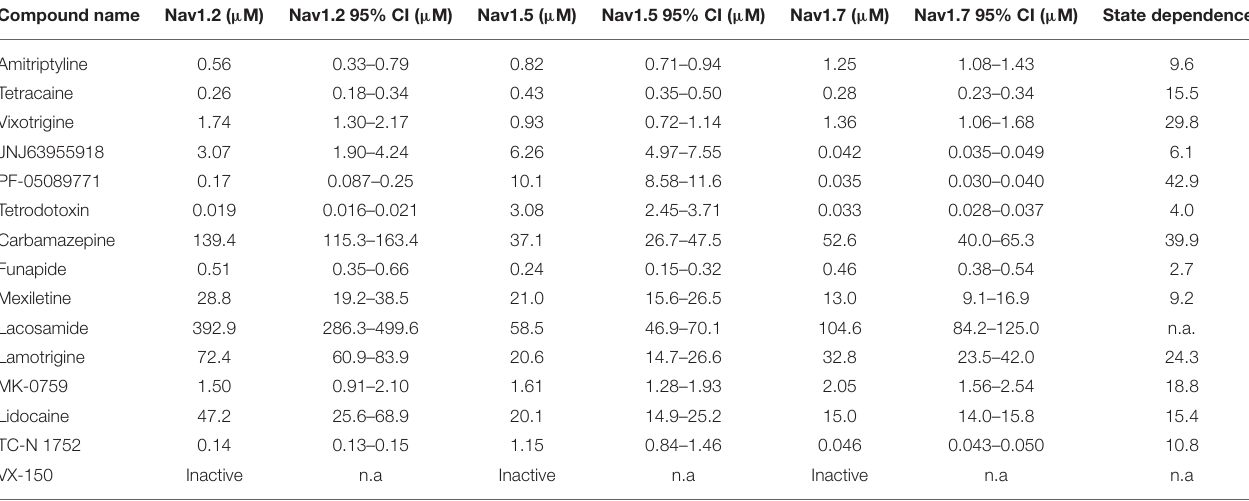
TABLE 1 | Tool compound